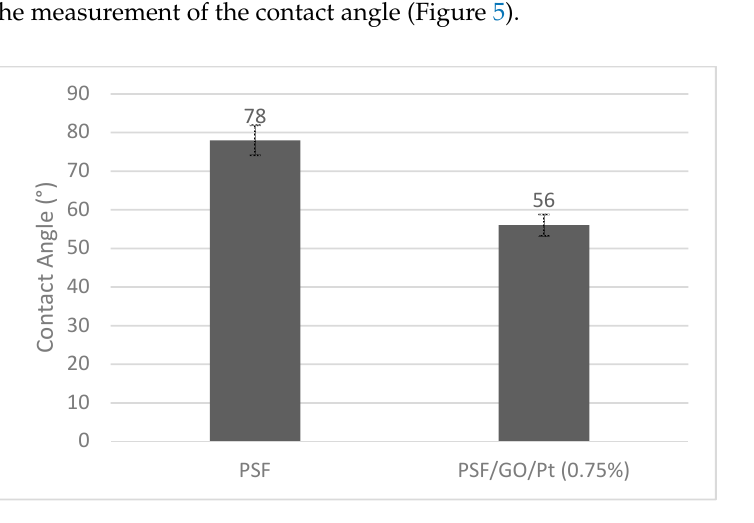
Figure 5. Water contact angle of the neat and modified membranes.